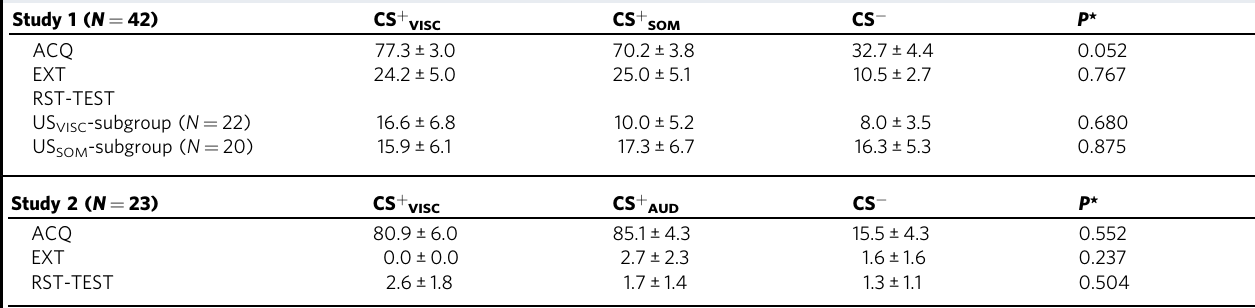
Table 2 Contingency awareness across learning phases.